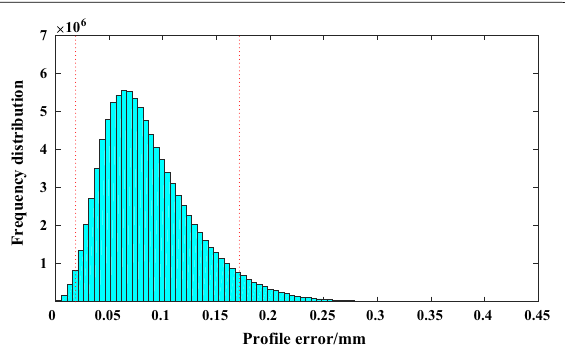
Figure 6 Frequency distribution of profile error in AMCM